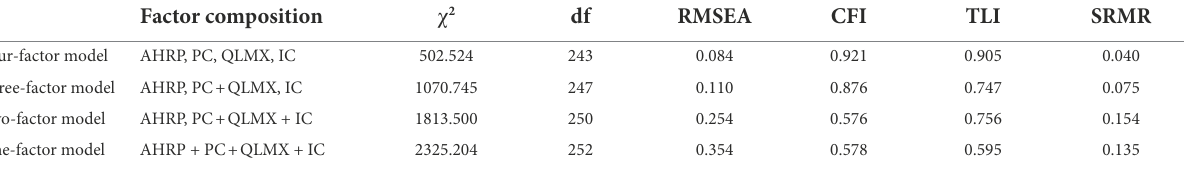
TABLE 1 Fitness indexes of scales.